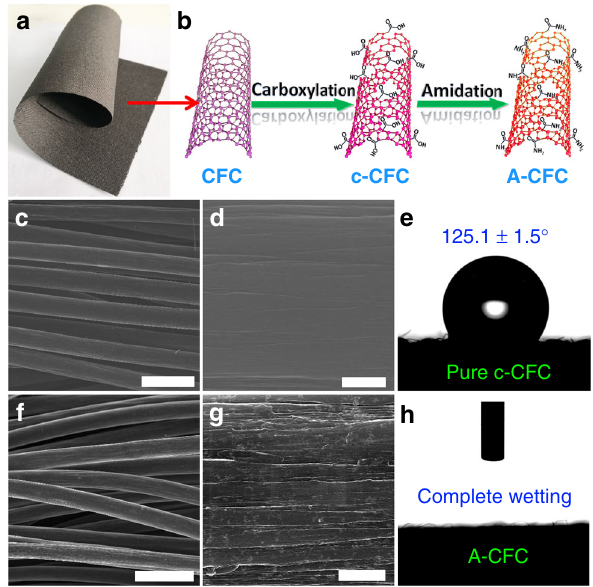
Fig. 3 SEM and surface wettability characterization of the samples. a Optical image of pristine CFC. b The two-step strategy for the synthesis of A-CFC, low-magni fi cation, and high-magni fi cation SEM images of c , d c- CFC and f , g A-CFC. e Pristine c-CFC is hydrophobic with a CA of 125.1 ± 1.5°. h After amidation, the obtained A-CFC becomes complete